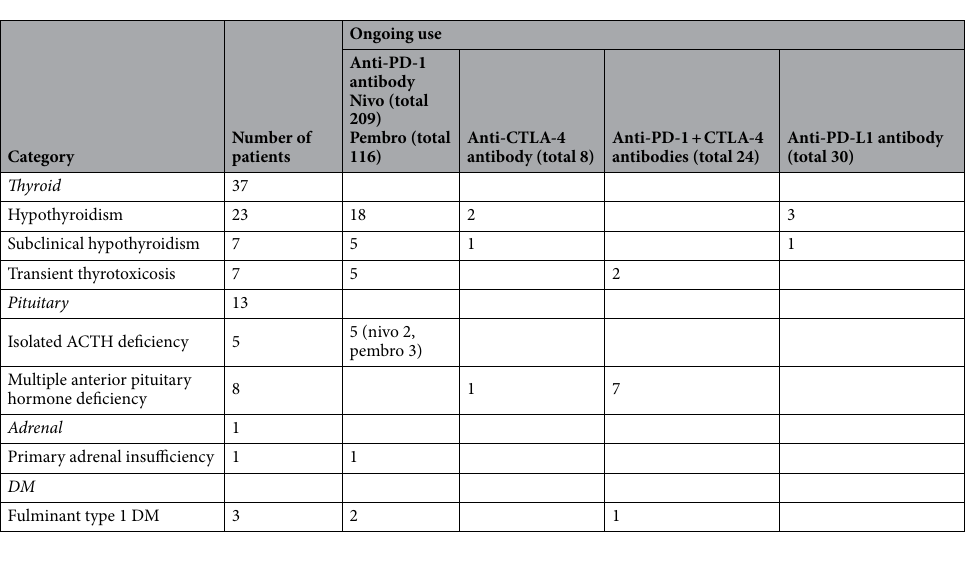
Table 2. Endocrine irAEs and ICI regimens used. ACTH, adrenocorticotropic hormone; ICI, immune checkpoint inhibitor; nivo, nivolumab; pembro, pembrolizumab; DM, diabetes mellitus.